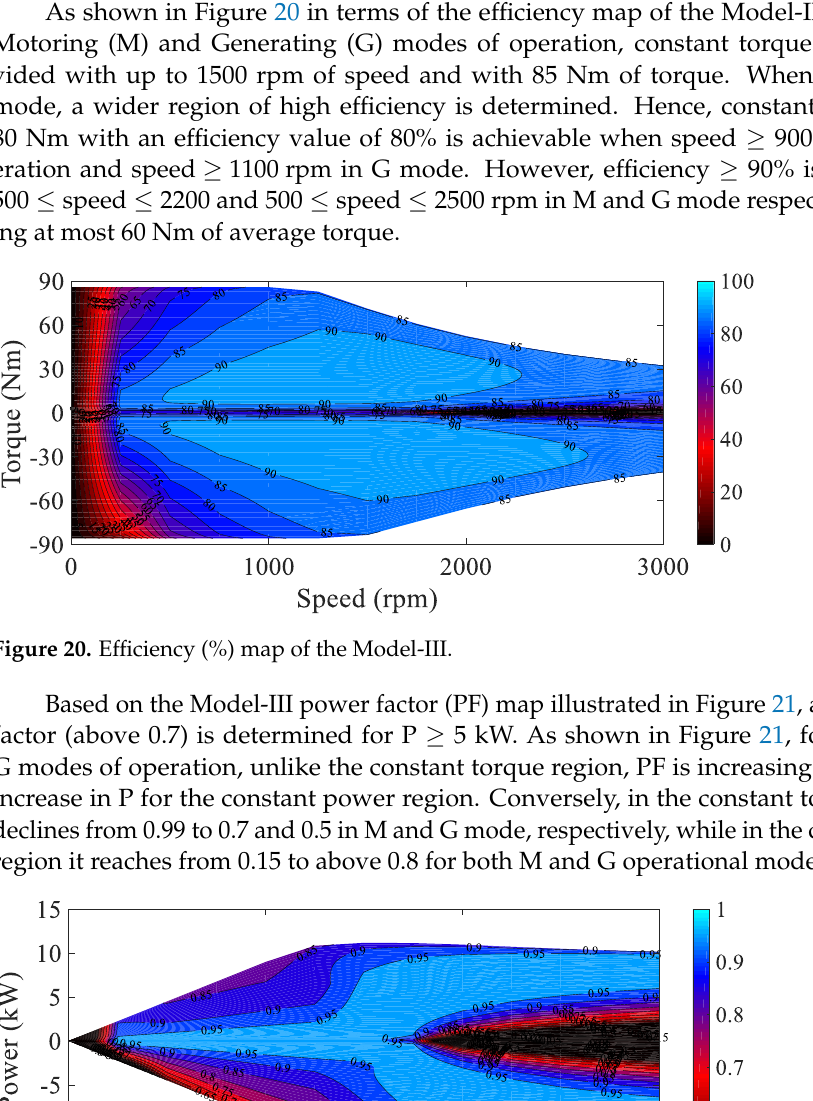
Figure 21. Power factor map of the Model-III.